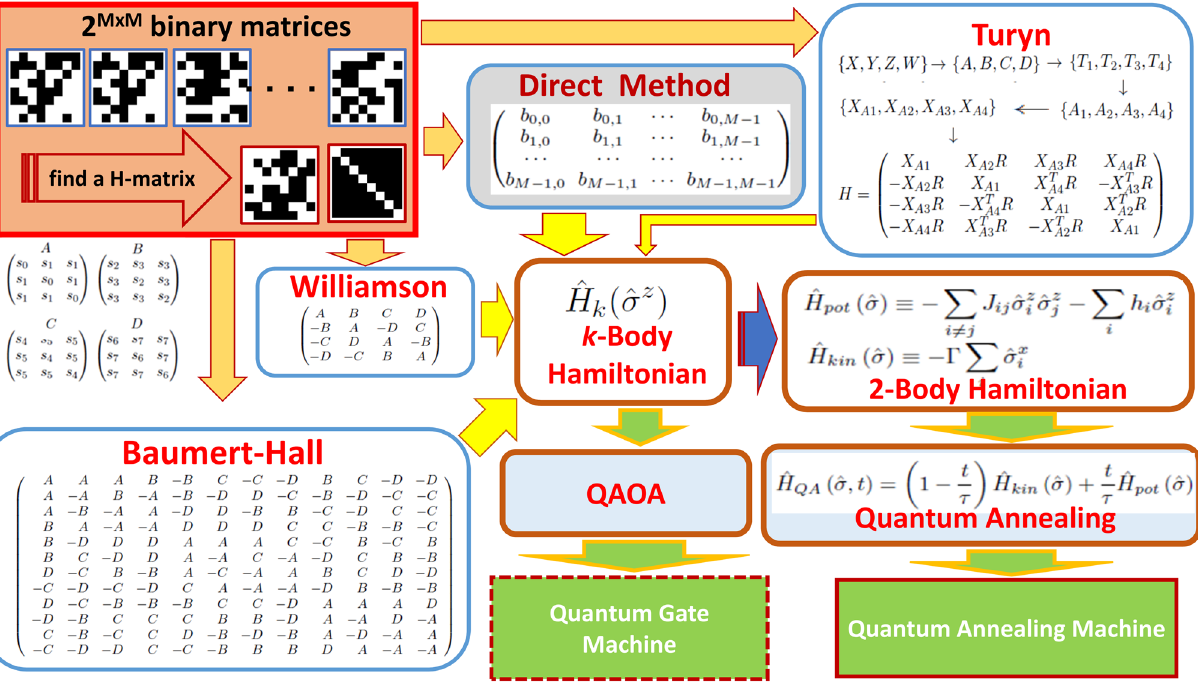
Figure 2. Quantum computing methods for solving the problem of finding H-matrix developed from classical methods. In the previous direct method 17 , we represent an M -order H-matrix to be found by an M × M binary variables, which becomes O ( M 2 ) logical qubits and O ( M 3 ) physical qubits including the ancillas, to be implemented on a quantum processor with Ising model. In this paper, we adopt three classical methods; i.e., the Williamson, Baumert–Hall, and Turyn, into quantum computing algorithms by formulating their corresponding